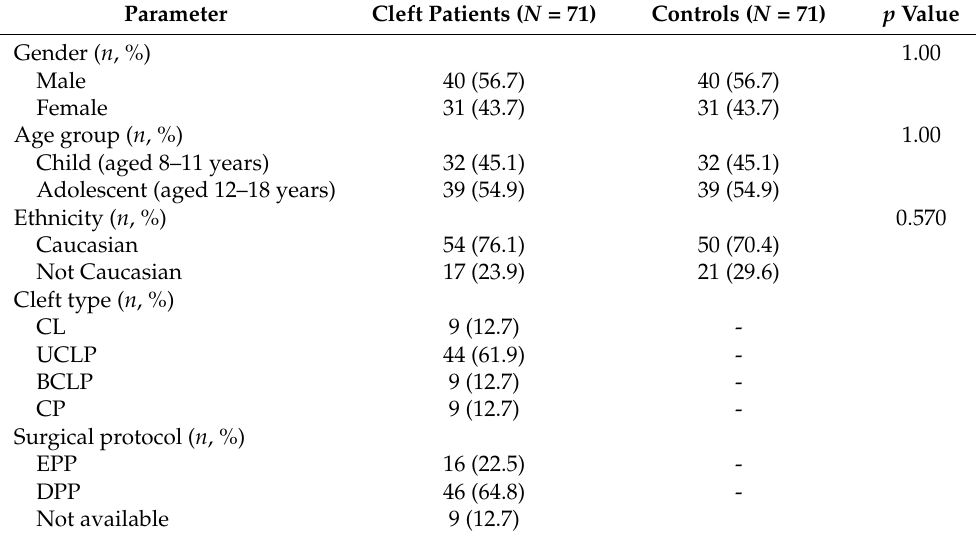
Table 1. General characteristics of the sample.